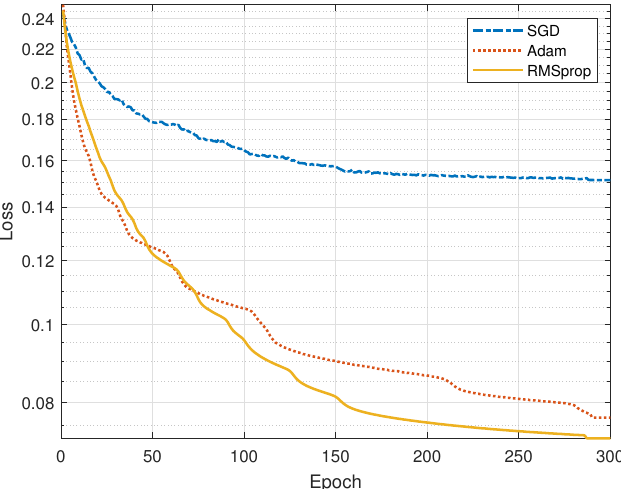
Figure 5. Training loss of several